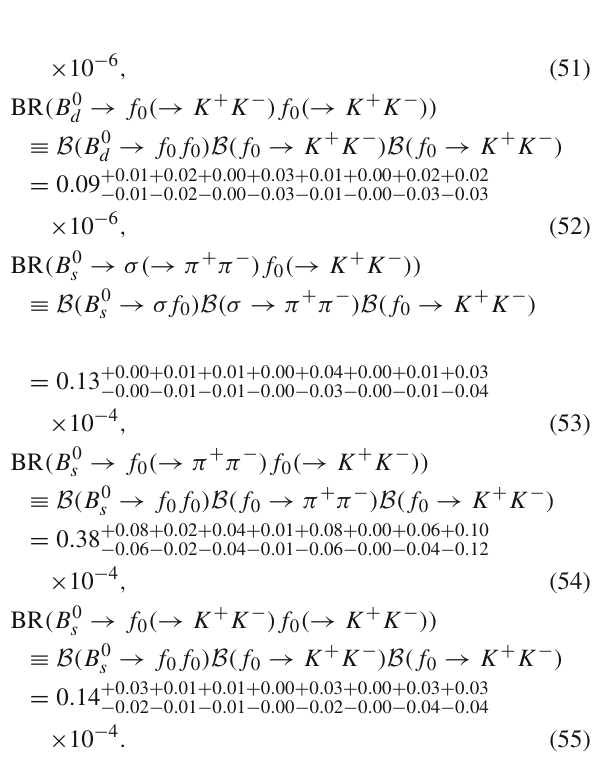
Table 3 The decay amplitudes (in units of 10 − 3 GeV 3 ) of the neutral B -meson decays into physical final states σσ,σ f 0 , and f 0 f 0 in the PQCD approach at leading order, where only the central values are quoted for clarifications. The mixing angle ϕ is taken as 25